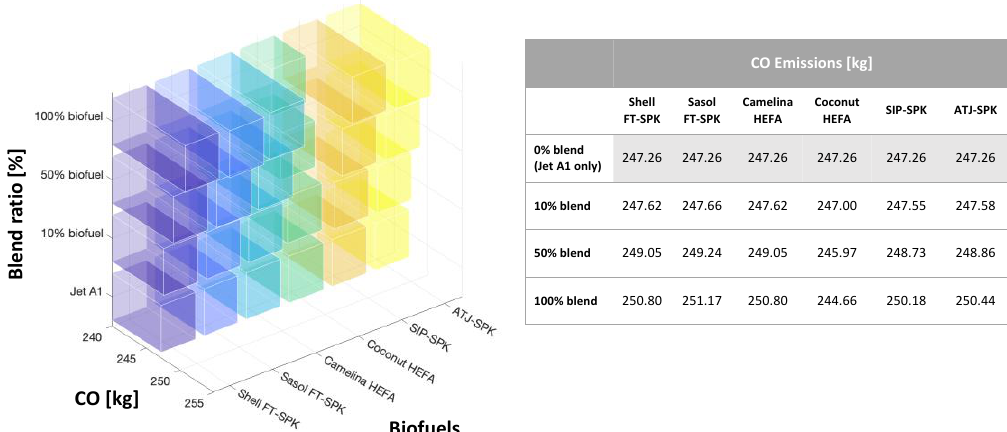
Figure 12. EI percentage variation due to different biofuel blending ratios.